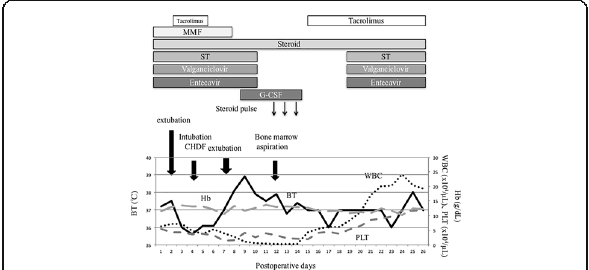
Fig. 1 Clinical course after liver transplantation. WBC, white blood cell count; PLT, platelet count; BT, body temperature; G-CSF, granulocyte- colony stimulating factor; MMF, mycophenolate mofetil; ST, trimethoprim/sulfamethoxazole; Hb,